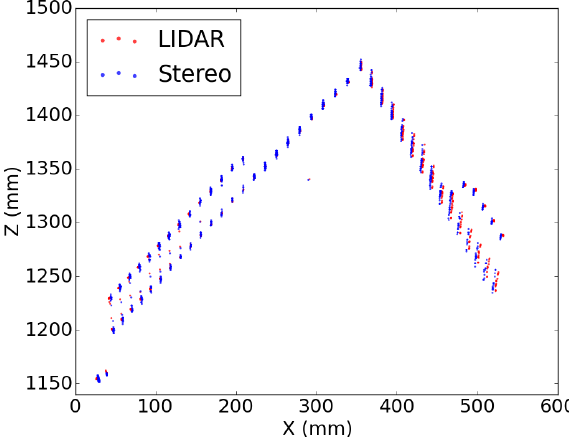
Figure 4 Overhead view of calibration points from each measurement system.